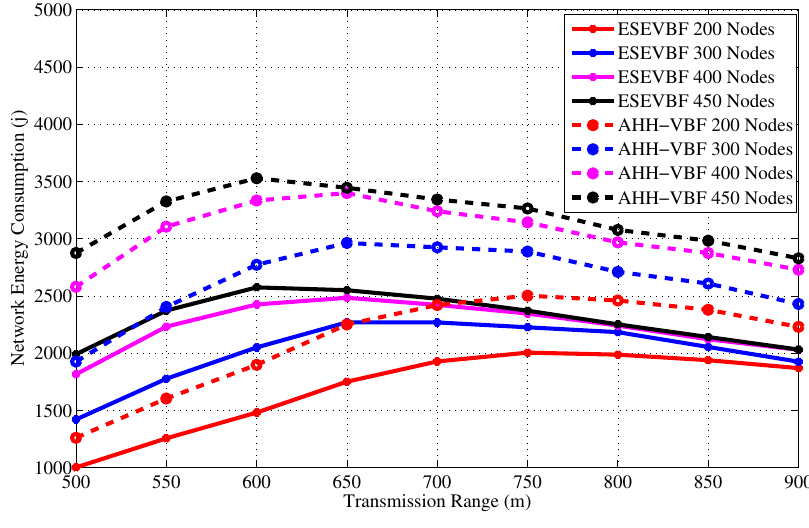
Figure 12. Overall network energy consumption versus the transmission